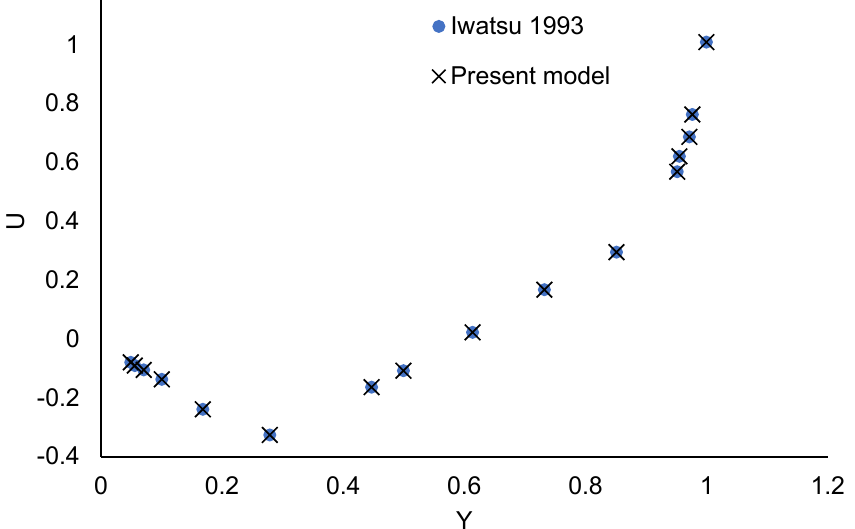
Figure Figure 2. Validation of code velocity profile [56] Reproduced with permission from [56]. Elsevier, 1993.